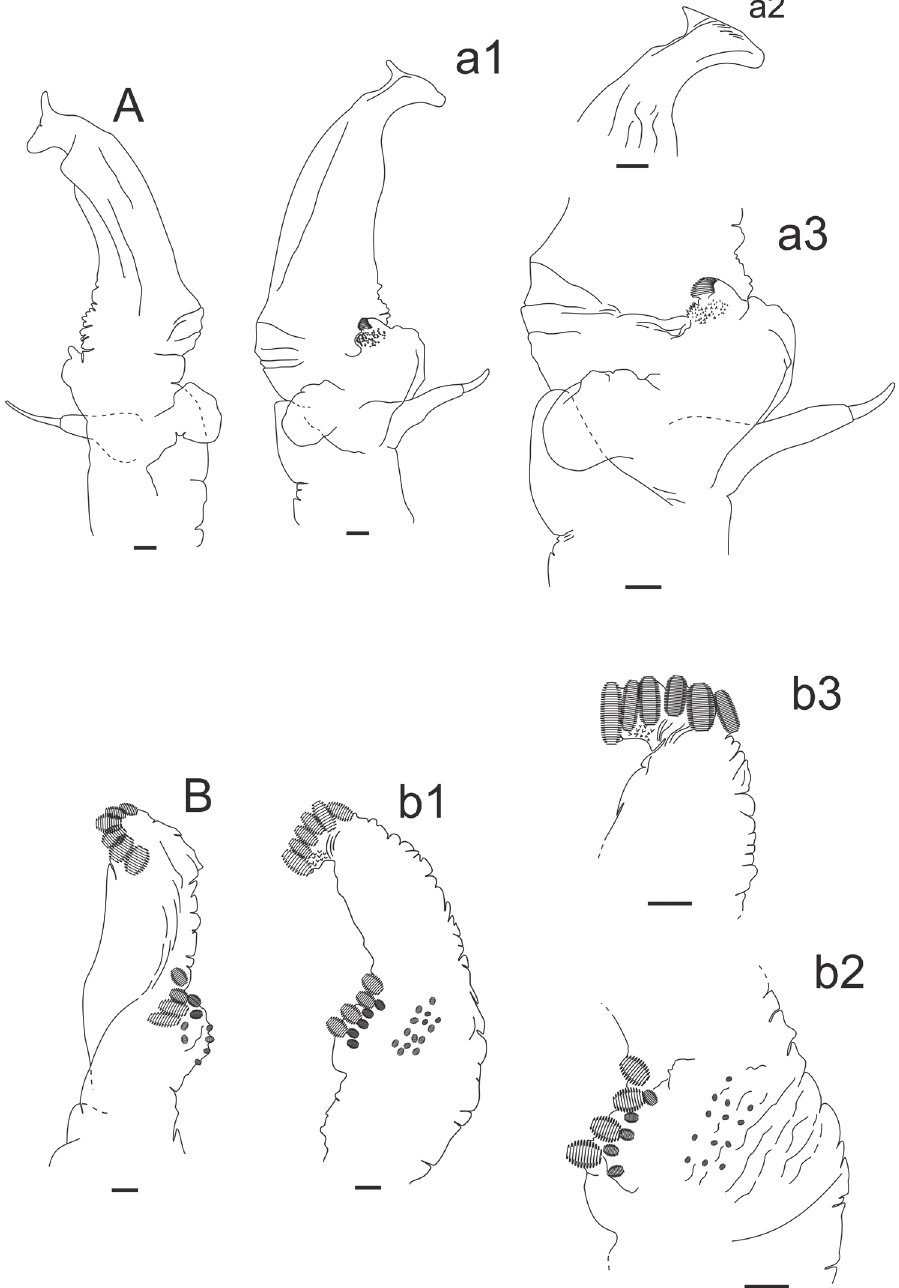
Figure 4. Dendrocephalus brasiliensis Pesta, 1971, male from Porto Real do Colégio, Alagoas, Brazil (CARCINO 104). A) branch 2A, rotated 180° (a1), details of the anterior end (a2) and basal spine and basal cell pad (a3); B) branch 2V, with branch rotated 90° (b1), showing the medial and medial-anterior rows of cell pads (b2) and details of cell pads in the bulge (b3). Scale bars = 0.1